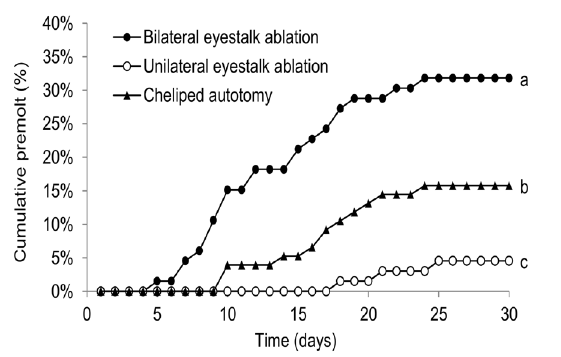
Figure 1. Cumulative premolt frequency in Callinectes ornatus subjected to different experimental treatments for 30 days. Different lowercase letters in rows indicate significant differences (p<0.001) among the experimental groups, calculated using the McNemar